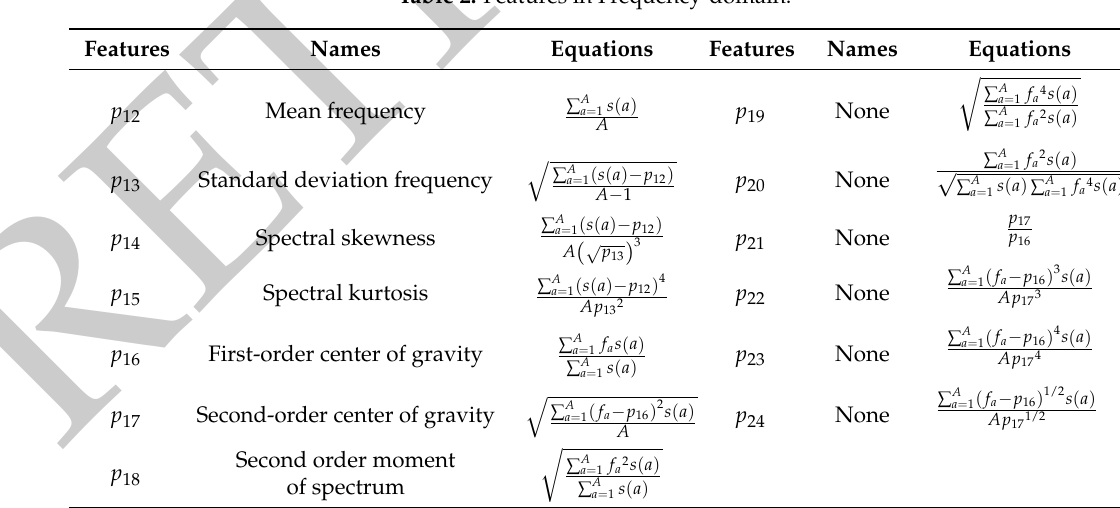
Table 2. Features in